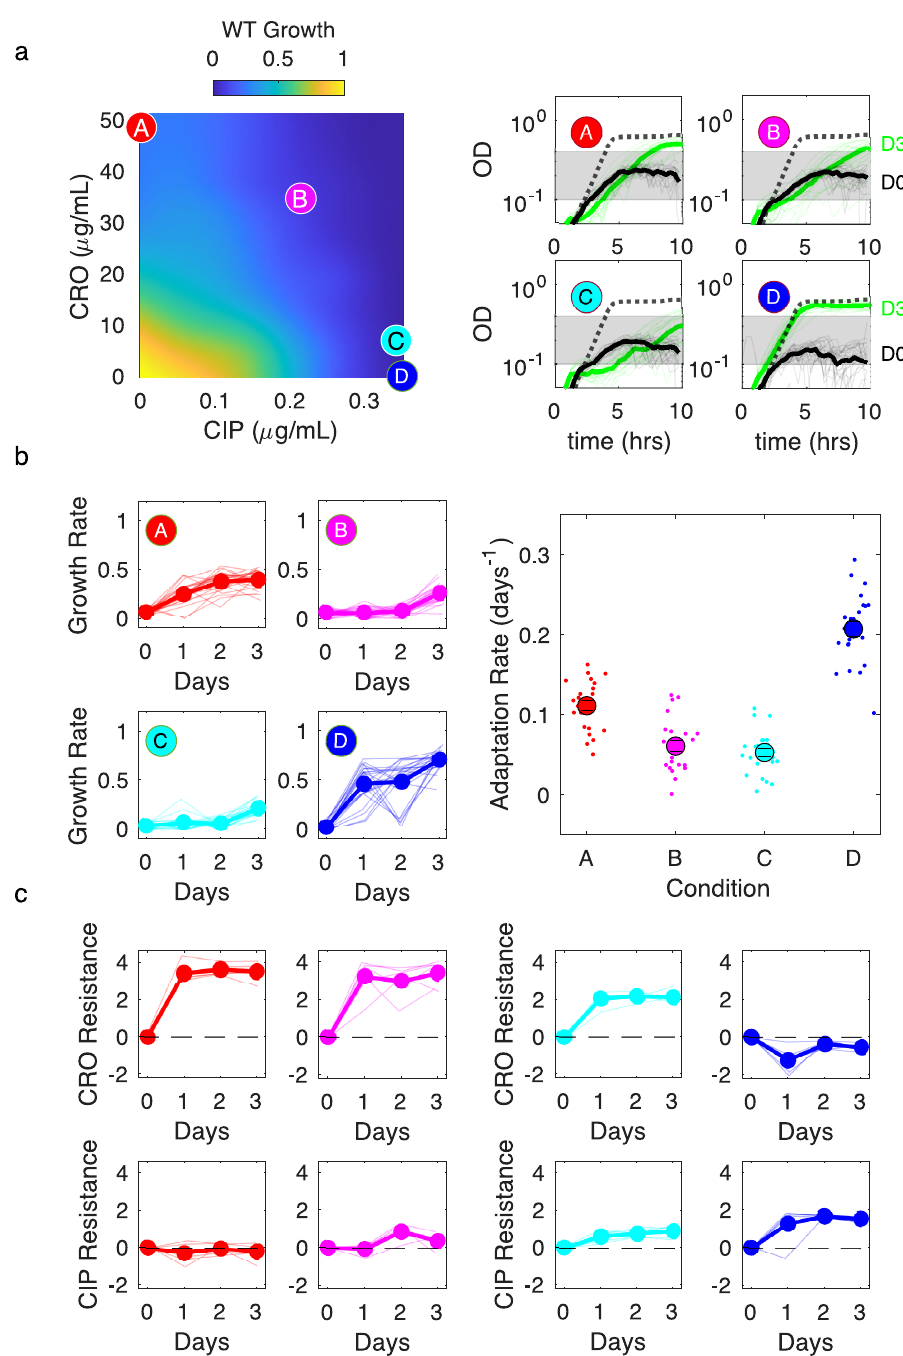
Fig 3. Antagonistic β -lactam and fluoroquinolone combination slows adaptation and selects for populations lacking observed collateral sensitivity of single-drug isolates. a) Left panel: per capita growth rate of ancestral populations as a function of ceftriaxone (CRO) and ciprofloxacin (CIP) concentrations. Circles correspond to different selecting conditions along a contour of constant inhibition. Drug concentrations (CRO, CIP) are (48.5, 0) (red, A); (34.7, 0.21) (magenta, B); (6.93, 0.34) (cyan, C); and (0, 0.46) (blue, D). The latter point is shifted for visualization. Right panels: growth curves for the first (black) and last (green) days of evolution for each condition. Dashed lines are drug-free growth curves in ancestor strains. Shaded region is OD range over which per capita growth rate is estimated. b) Left panels: per capita growth rate over time for each condition. Right panel: average rate of growth adaptation over the course of the evolution. Adaptation rate in the single drug conditions (red and blue conditions, combined) is greater than that in the combined drug conditions (magenta and cyan, combined), 1-sided t-test (unequal variance),